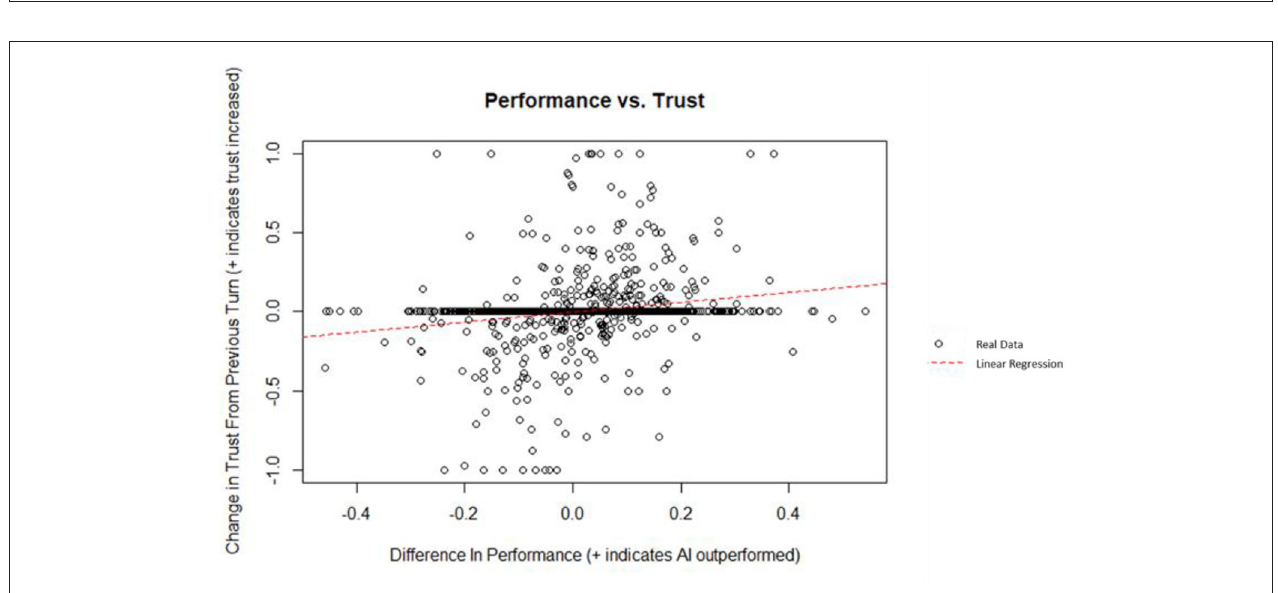
FIGURE 9 | Difference in performance vs. change in